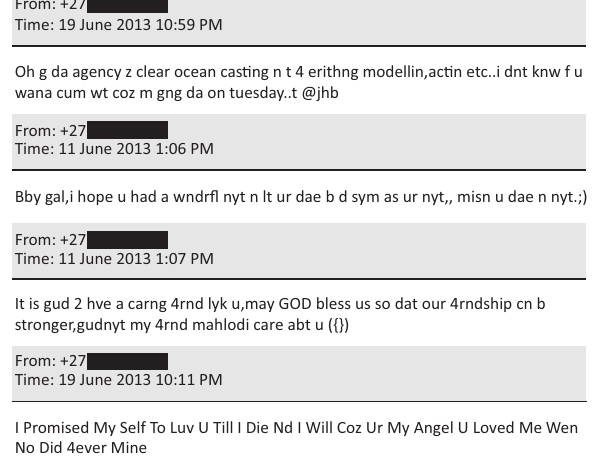
FIGURE 2: Sample of 2nd set of participants’ SMS language features and corresponding full Versions. Table 2 (on electronically transferred SMSes) indicates 13 textism categories; the first eight in the following descending order of frequency occurrence being: initialisms and alphabetisms; phonetic approximations; misspellings